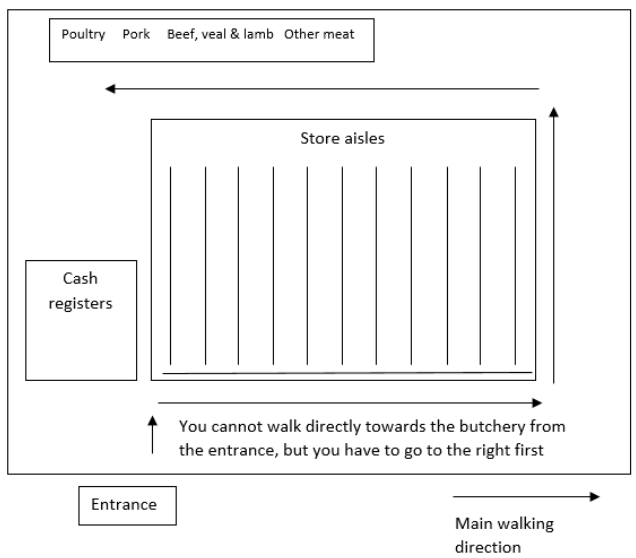
Figure A1. Schematic overview of the store environment in the experimental and control store.